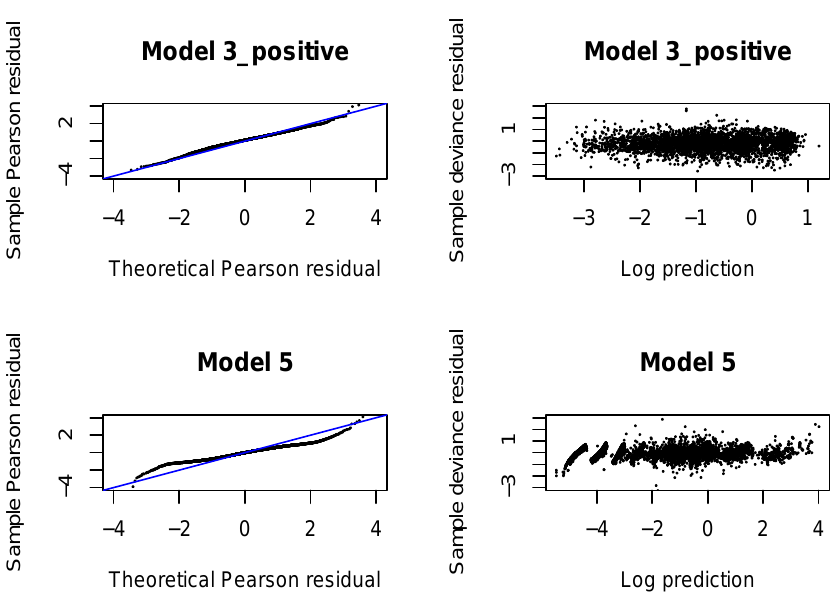
Figure A16. QQ normal plots and Tukey-Anscombe plots in Models 3_positive and 5 fitted with neural